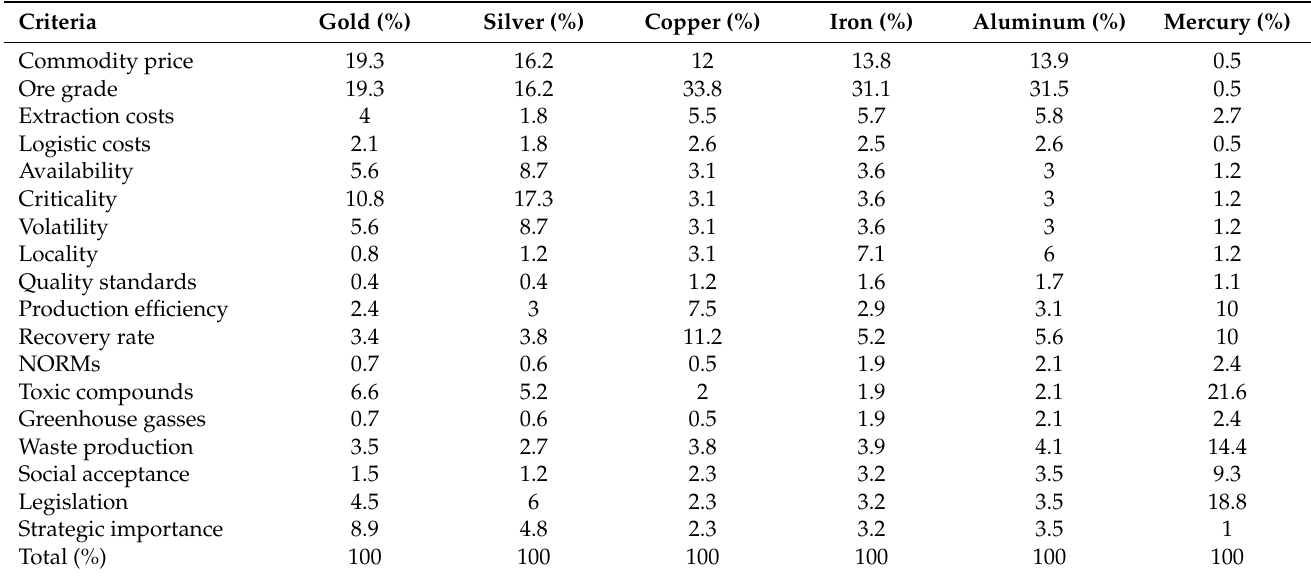
Table 8. Calculated global criteria for all potential products in the Chovdar